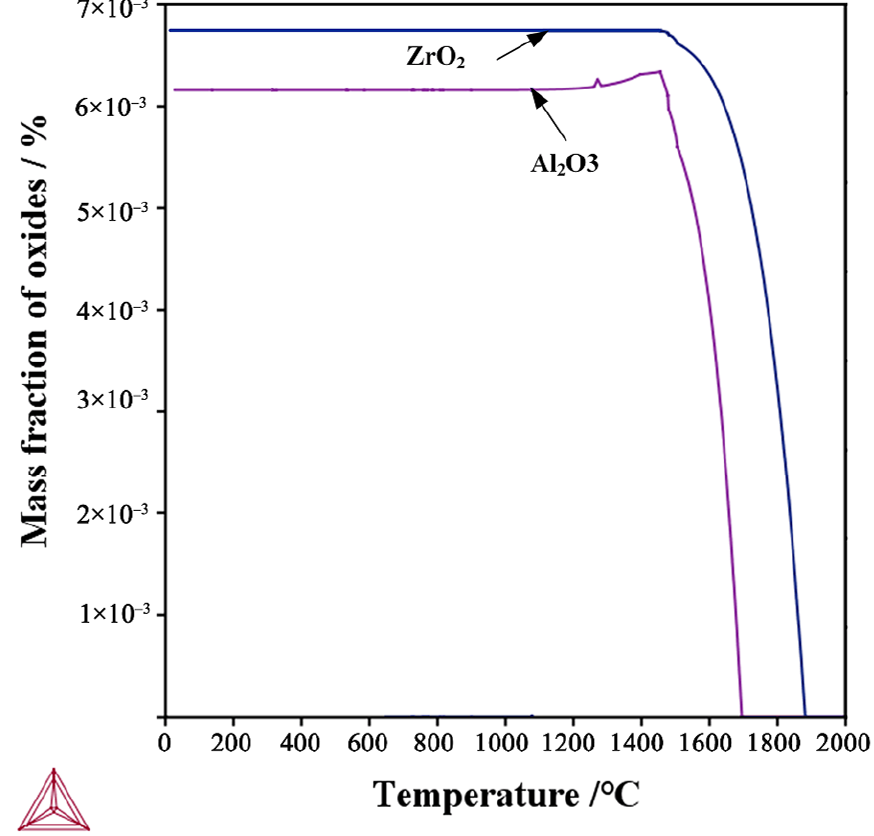
Figure 3. Mass fractions of oxide calculated by ThermalCalc for the Al-Steel and